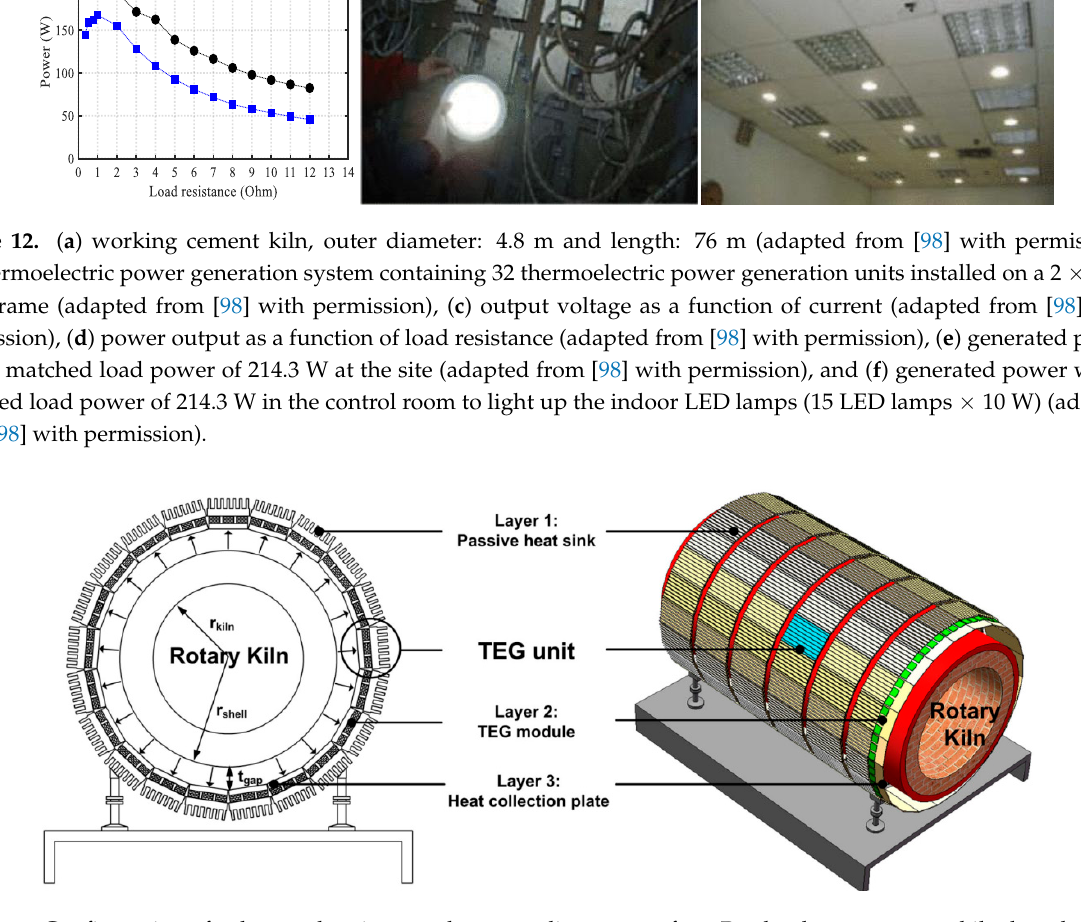
Figure 12. ( a ) working cement kiln, outer diameter: 4.8 m and length:76 m (adapted from [98] with permission), ( b ) ther- moelectric power generation system containing 32 thermoelectric power generation units installed on a 2 × 1 m 2 steel frame (adapted from [98] with permission), ( c ) output voltage as a function of current (adapted from [98] with permission), ( d ) power output as a function of load resistance (adapted from [98] with permission), ( e ) generated power with a matched load power of 214.3 W at the site (adapted from [98] with permission), and ( f ) generated power with a matched load power of 214.3 W in the control room to light up the indoor LED lamps (15 LED lamps × 10 W) (adapted from [98] with permis- sion).